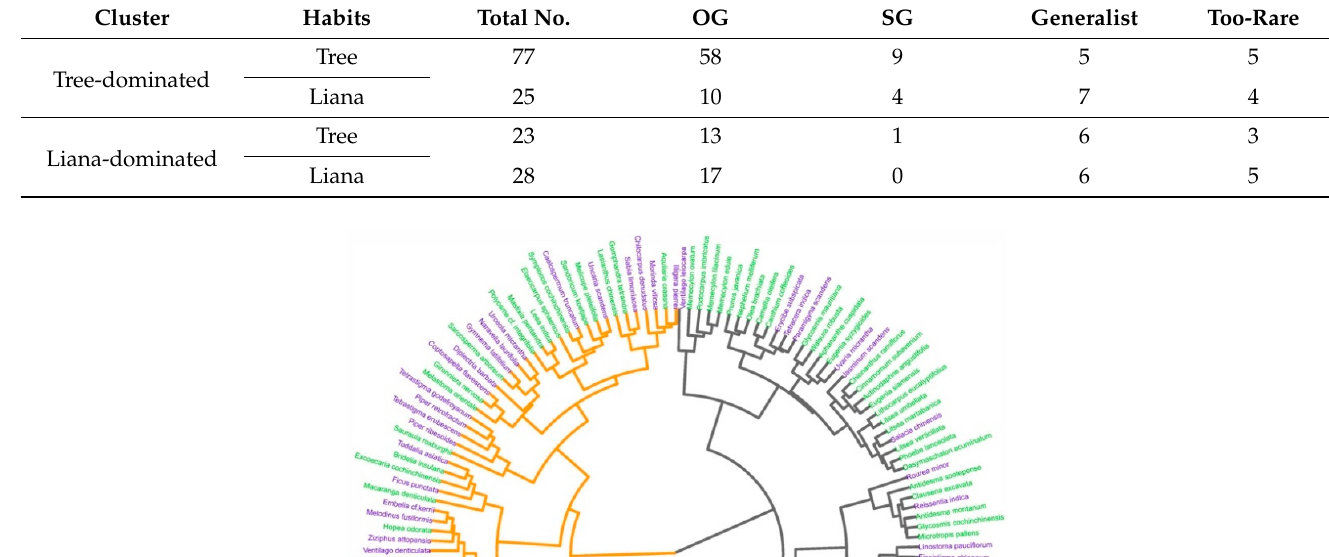
Figure 1. Trait averages of functional groups of lianas and trees. Bars represent marginal means and error bars show SE (95% confidence level) for ( a ) specific leaf area (SLA) and ( b ) specific stem length (SSL). Letters at the top of bars indicate significant ( p < 0.05) differences among different clusters based on Tukey’s HSD tests. Table 2. Summary of species classification in two clusters. Cluster refers to the classification of species based on all traits. Habits refer to the functional group of trees or lianas, OG indicates species classified as specialists of old-growth forests, SG indicates species classified as specialists of secondary-growth forests, Generalist indicates species are specialists in both types of forests, Too-rare indicates species that do not have enough individuals for classification.